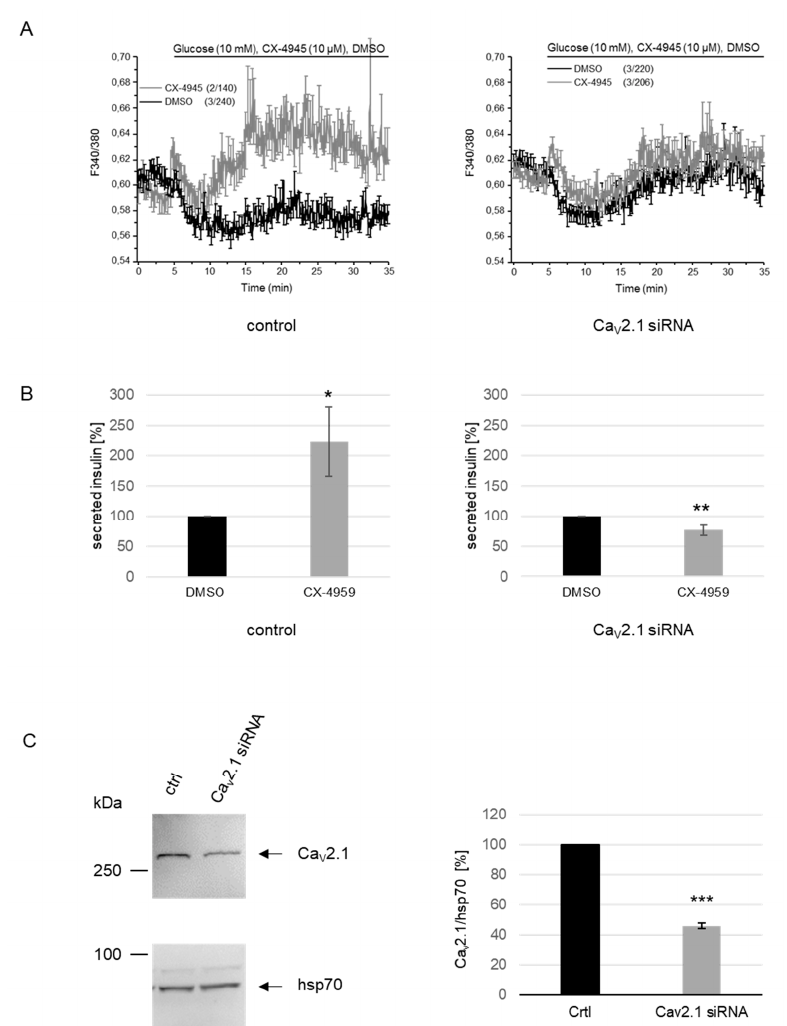
Figure 4. Knockdown of Ca V 2.1 expression abolishes the CX-4945-induced increase in the cytosolic Ca 2 + concentration and enhanced insulin secretion in INS-1 cells. ( A – C ): INS-1 cells were transfected with Ca V 2.1 siRNA or scrambled control siRNA (200 nM), together with the fluorescent transfection indicator siGlo for 48 h. ( A ) Ca 2 + imaging experiments after Ca v 2.1 knockdown. Prior to the measurement, the cells were starved for 2 h in glucose-free medium. Cells were then incubated with the CK2 inhibitor CX-4945 (10 µ M) or the solvent DMSO as a control and insulin secretion was induced with glucose (10 mM). Calcium imaging was only done in those cells where the successful transfection was indicated by siGlo. Changes in [Ca 2 + ] were determined by Fura 2-AM (5 µ M) measurements and plotted versus time. Each trace represents the mean ± SEM of fluorescence ratios ( F 340 / 380 ) of two or three independent experiments of the total number of cells indicated in brackets. ( B ) Cell culture supernatants of cells treated as described for A were collected and analyzed for secreted insulin by an ELISA assay. Determination was done in three independent experiments with two technical replicates each and values were normalized to the respective DMSO control. Data are expressed as means ± SEM. Statistical analysis was performed by using Student’s t -tests. * p < 0.05, ** p < 0.01. ( C ) Equal amounts of extracts from all cells were analyzed by SDS polyacrylamide gel electrophoresis and subsequent immunoblot analysis with anti-Ca V 2.1- or anti-hsp70-specific antibodies (left panels). A representative immunoblot is shown. Ratios between the arbitrary amount of Ca V 2.1 and the loading control hsp70 were quantified by densitometry (Ca V 2.1 / hsp70) and compared with the corresponding control value normalized to 100% (right panel). Data are expressed as means ± SEM of three independent experiments. Statistical analysis was performed by using Student’s t -tests. *** p <